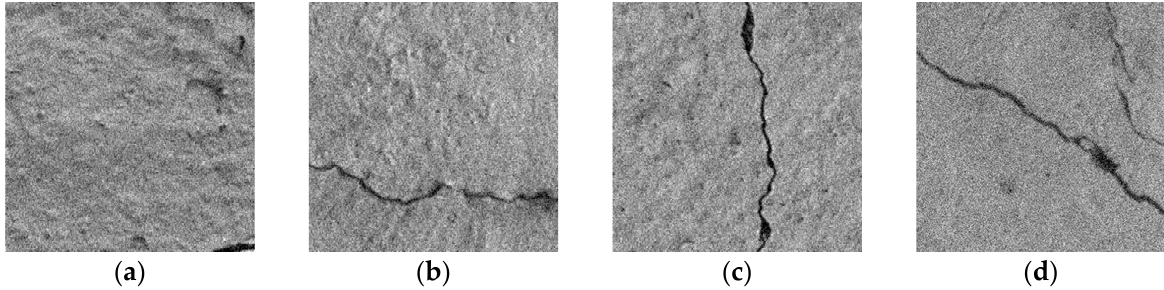
Figure 1. Examples of different types of images in the dataset: ( a ) Without crack; ( b ) longitudinal crack; ( c ) transverse crack; ( d ) oblique crack.